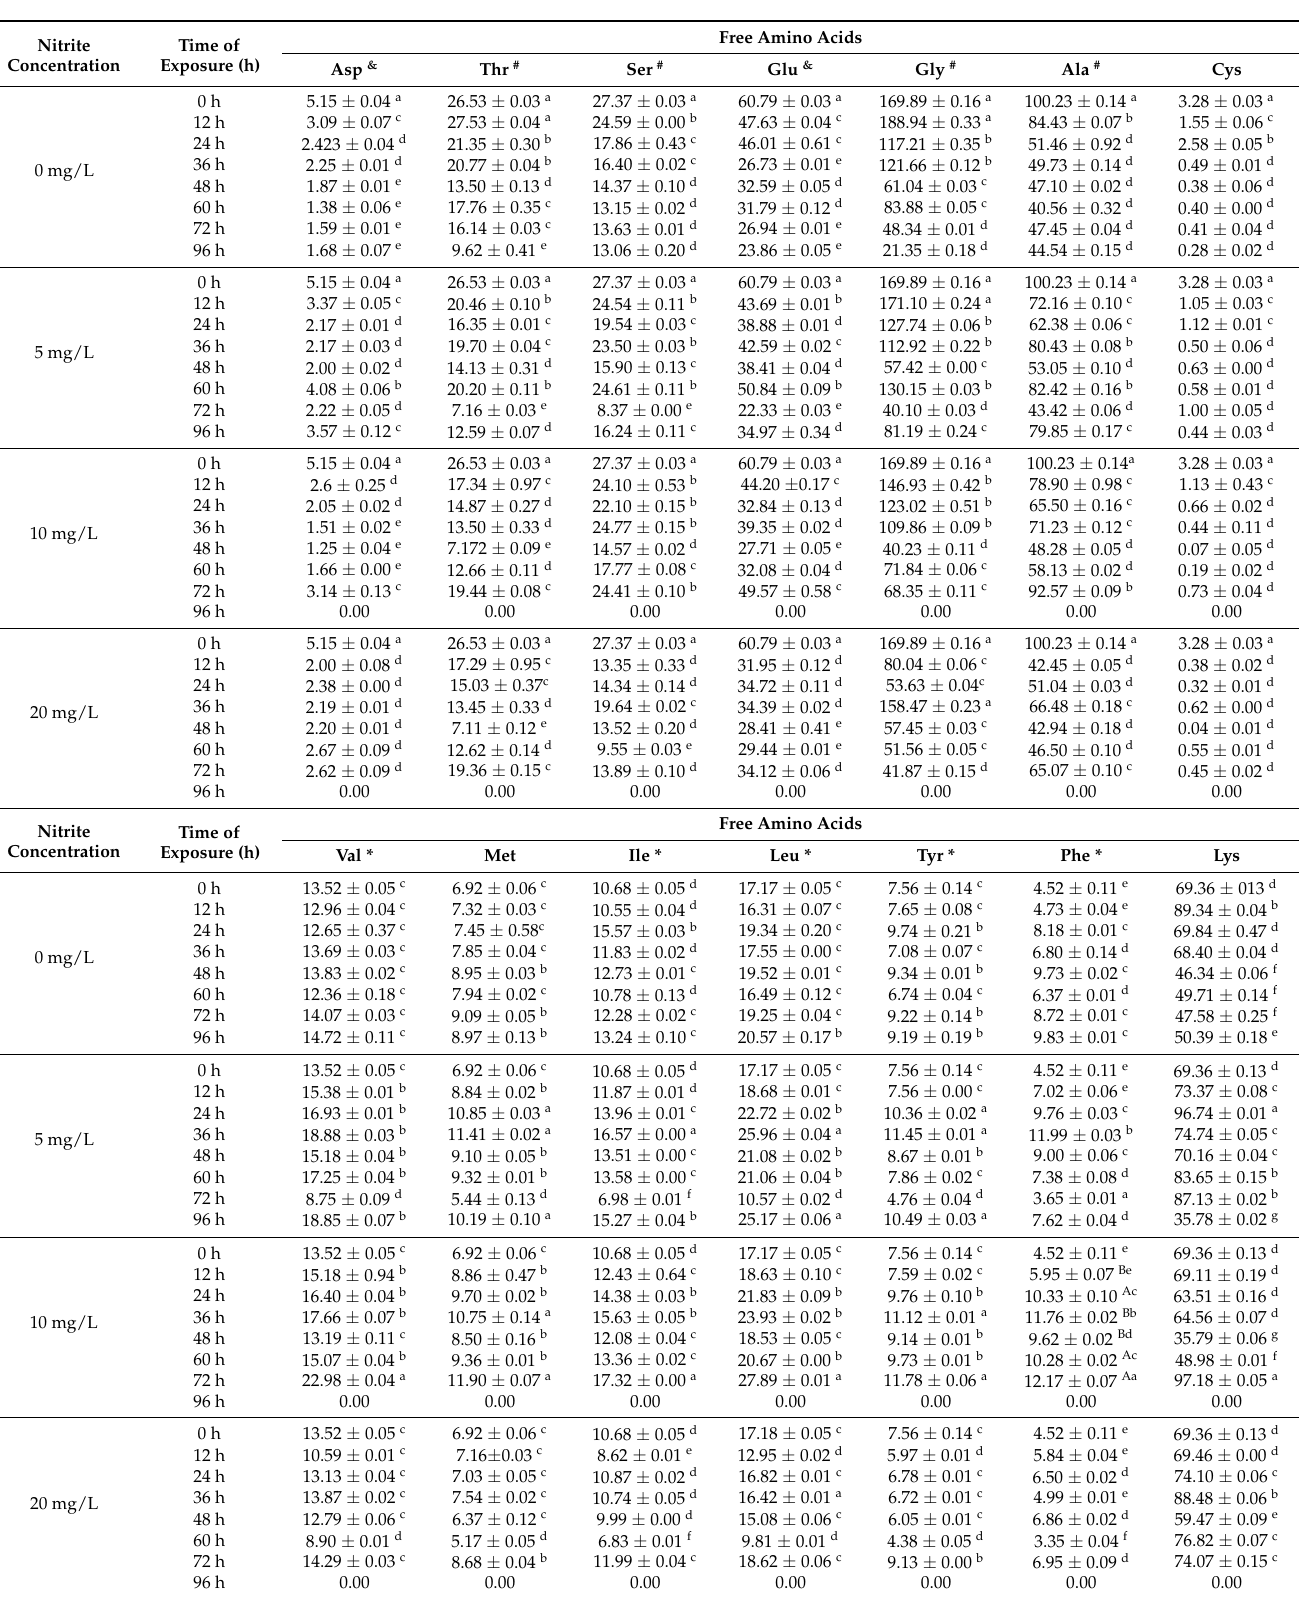
Table 3. Changes in FAAs of pearl gentian grouper exposed to various concentrations of nitrite for 96